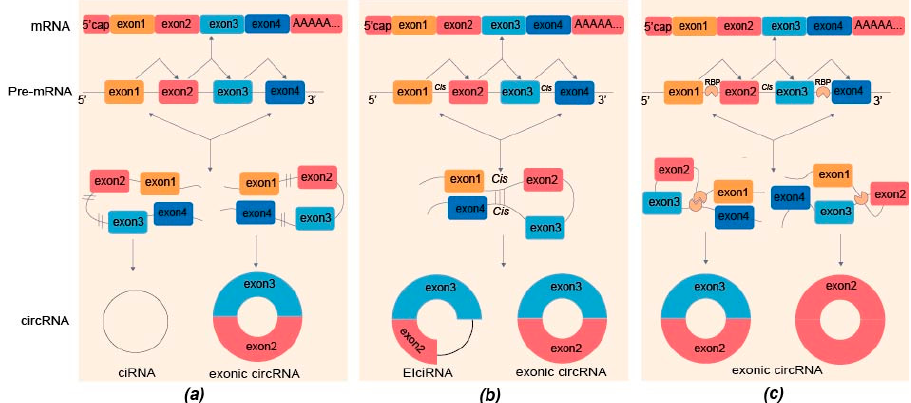
Figure 1. Mechanism of circRNAs biosynthesis. ( a ) Back-splicing: Spliceosomes connect downstream 5 ′ and upstream 3 ′ splice sites to form circRNAs by reverse splicing pre-mRNA; ciRNA is generated when the intron escapes the branching lasso during the canonical splicing process of exon circularization. ciRNA, intronic circRNA. ( b ) Cis -regulation elements: the cis -element makes RNA pairing between introns on either side of the exon easier by reducing the spatial obstruction of back-splicing. There are many RNA pairs in flanking introns and inverted repeat Alu elements, and exon cyclization, depends on the complementary sequence of flanking introns. The Alu element in introns can promote the production of EIciRNA. EIciRNA, exon–intron circRNA. ( c ) Two RNA-binding protein patterns regulate circRNAs biosynthesis. RBP binds to other RBPs or intron sequences to form exonic circRNAs by back-splicing. RBP, RNA binding protein.